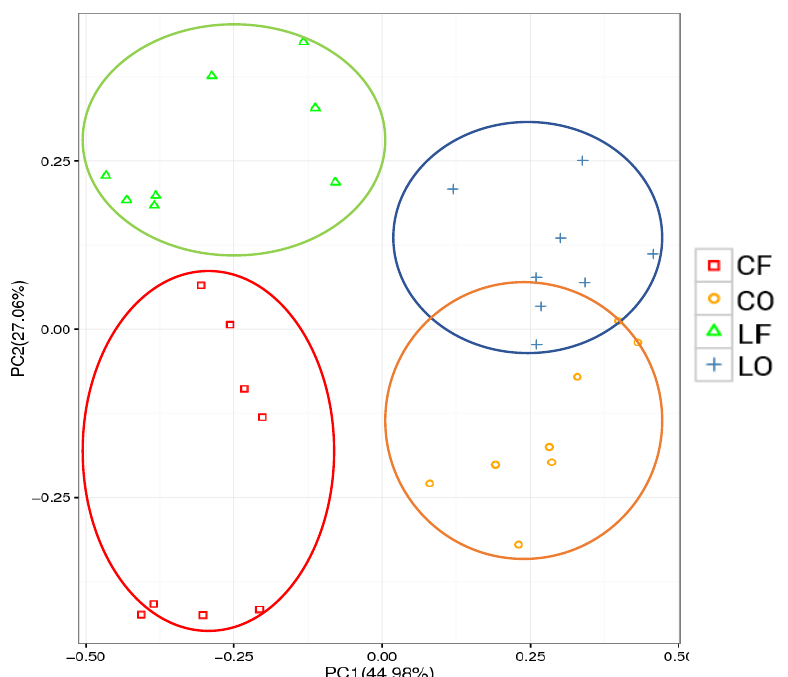
Figure 6. Principal components analysis (PCA) on operational taxonomic units (OTU) level, repre- senting overall composition similarity and dissimilarity among groups of hamsters fed one of the four diets: CF, fresh corn oil; CO, oxidized corn oil; LF, fresh lard; LO, oxidized lard.